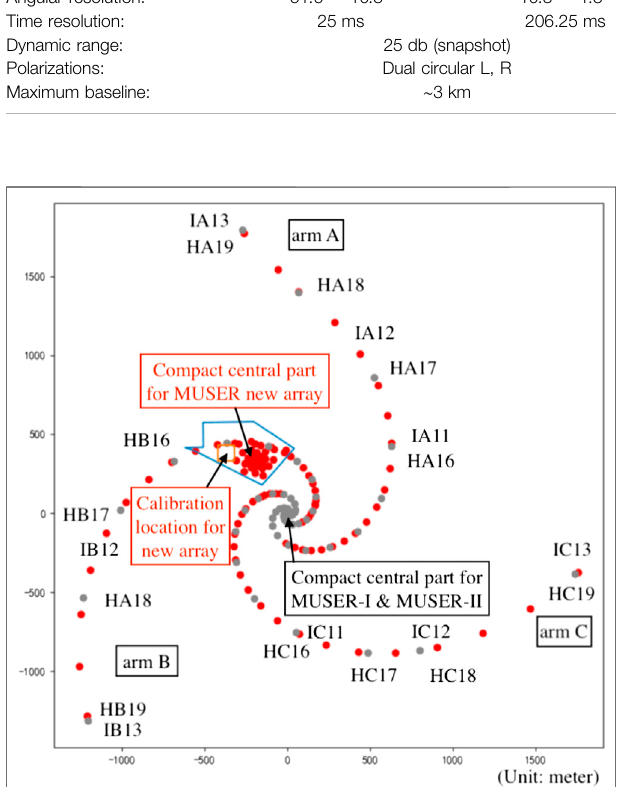
FIGURE 2 | The array con fi guration for extension of MUSER to lower frequency range of 30 – 400 MHz with black dots indicating existing MUSER-I and MUSER-II antennas whereas red dots indicating the locations for the newly designed 100 LPDAs. The blue area is the region where the compact central part of the new MUSER low frequency array will be located. Theredsquareindicatesthelocationwherethecompactcalibrationarraywith 124 LPDAs will be placed. Some MUSER-I and MUSER-II antenna locations are marked with corresponding antenna numbers.